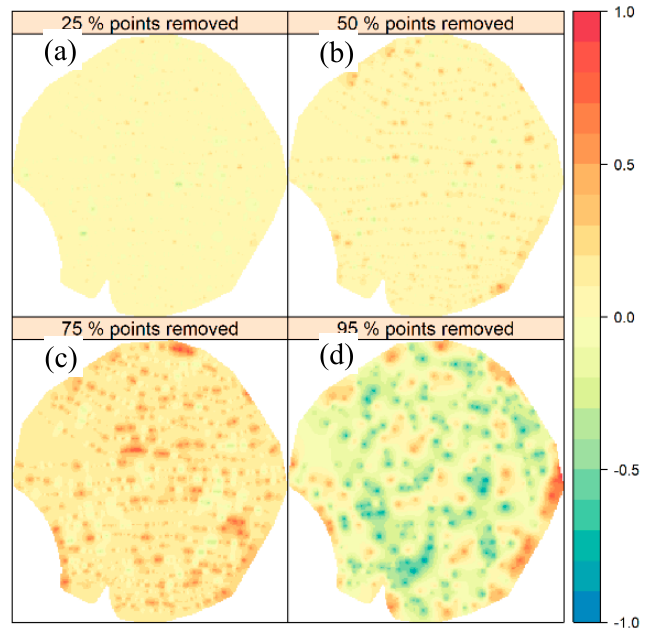
Figure 11. Di ff erences between standard deviations of ECa from interpolations using random selection Figure 11. Differences between standard deviations of ECa from interpolations using random and Douglas-Peucker algorithms on di ff erent sample density reductions: 25% ( a ); 50% ( b ); 75% ( c ); and selection and Douglas-Peucker algorithms on different sample density reductions: 25% ( a ); 50% ( b ); 95% ( d 75% ( c ); and 95% ( d ).